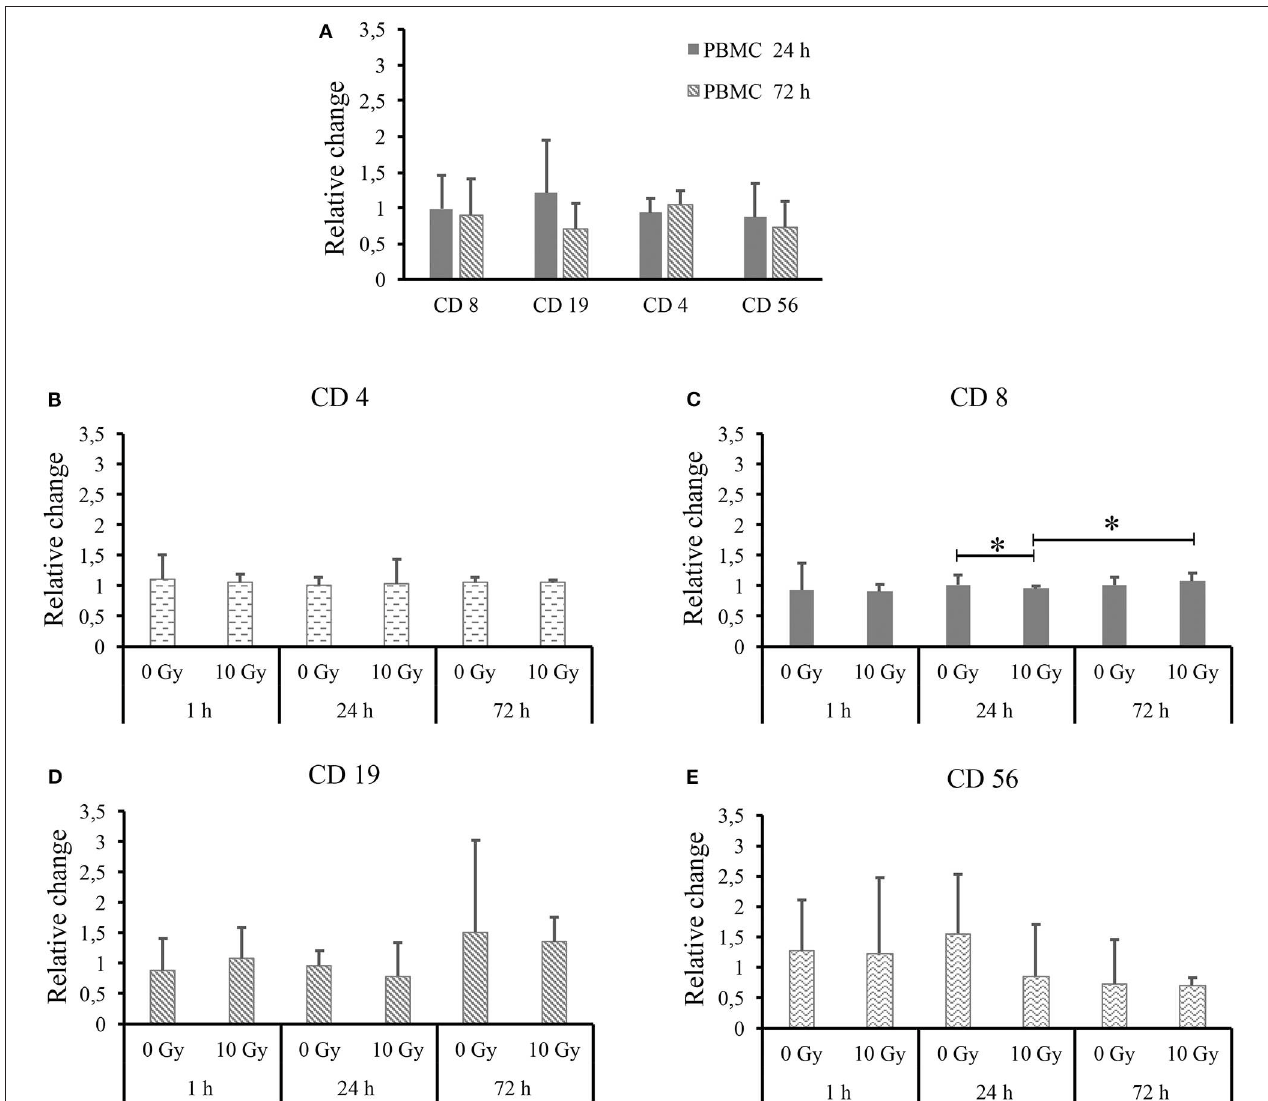
FIGURE 4 | Average relative changes in PBMC subset populations for all donors. (A) For PBMCs cultured alone, relative changes in CD4 + , CD8 + , CD19 + , and CD56 + subsets as a function of time with respect to the 1h time-point. For PBMCs co-cultured with both non-irradiated and 10 Gy-irradiated Caco-2 cells, relative changes with respect to PBMCs cultured alone at the same time-point for subsets: (B) CD4 + ; (C) CD8 + ; (D) CD19 + ; and (E) CD56 + . Ratios are calculated for individual donors (excluding outliers identified in Figure 3 ) and then averaged. Errors are obtained as standard deviations. Statistical significance ( p < 0.05) is calculated by two-tailed Student’s t